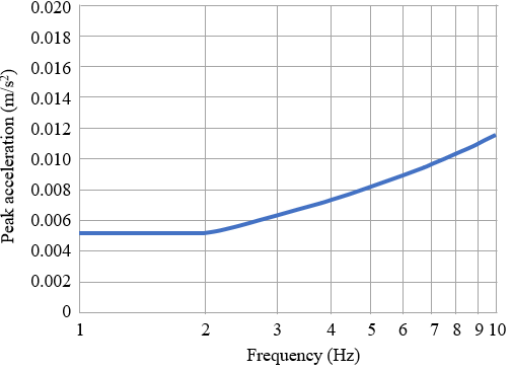
Figure 4. The threshold of lateral accelerations at different frequencies as specified by ISO. Table 3. Simulation results of the lateral accelerations of the bridge under pedestrian